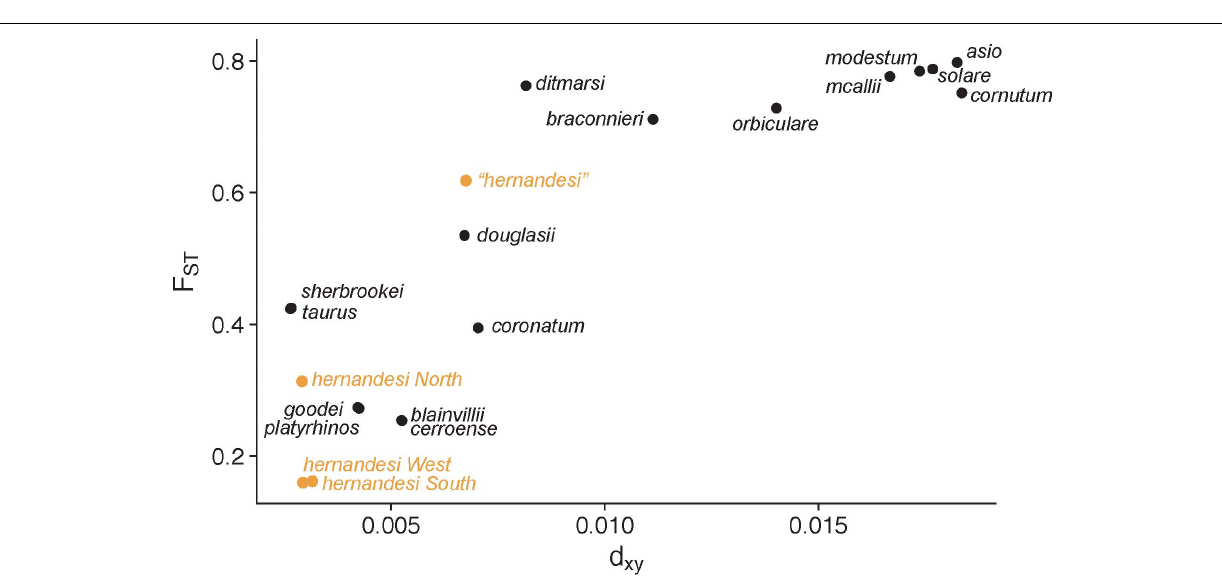
incomplete lineage sorting. We were not able to include